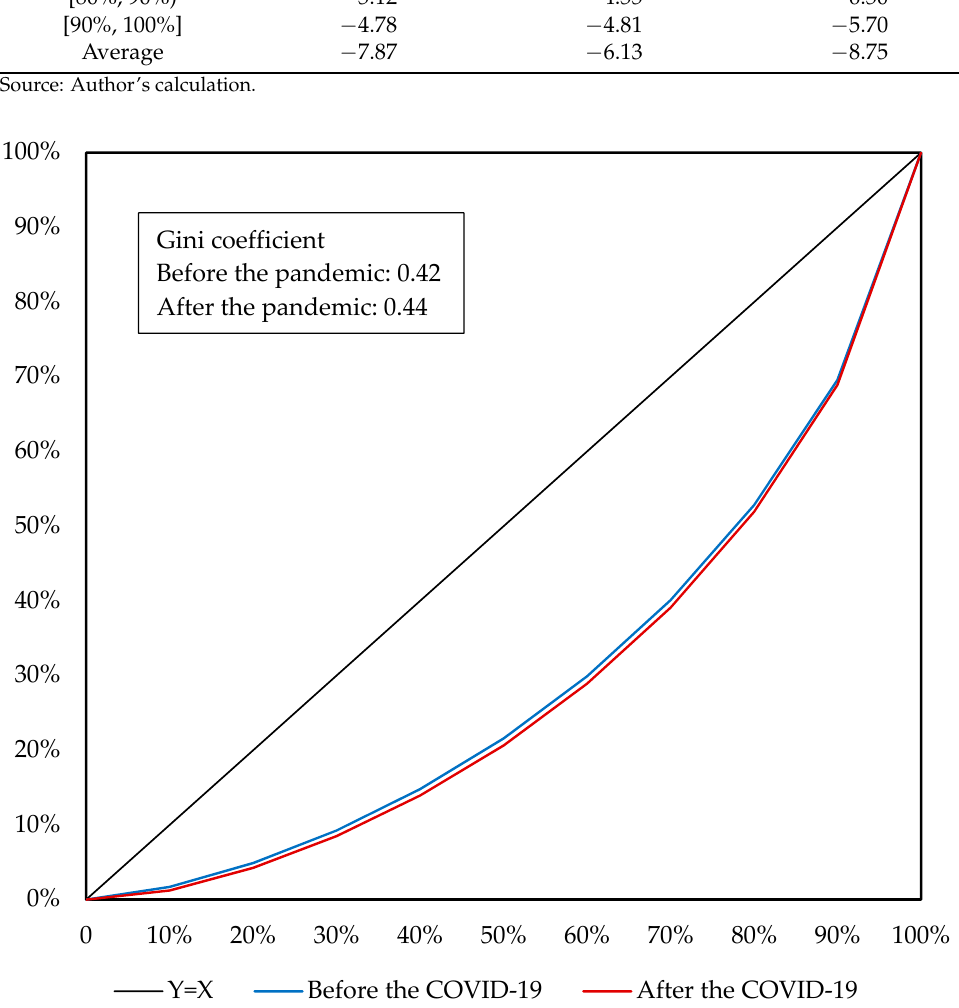
Figure 7. Lorentz curve of all residents before and after the COVID-19 pandemic. Source: Author’s calculation.